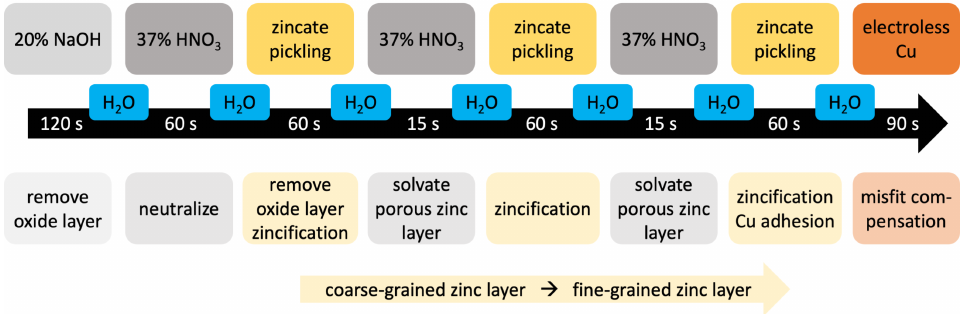
Figure 2. Schematic of the pre-treatment process and the aim of each